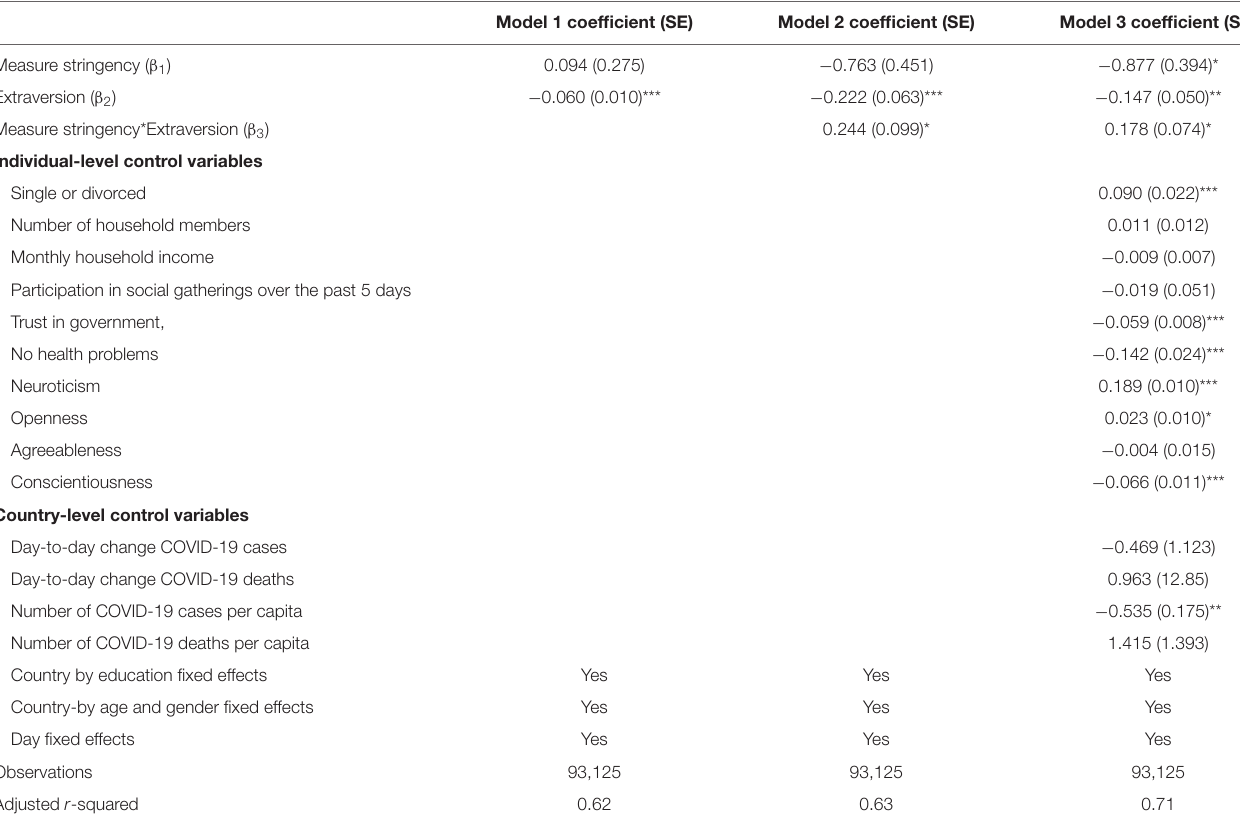
TABLE 4 | Results of regression analyses.